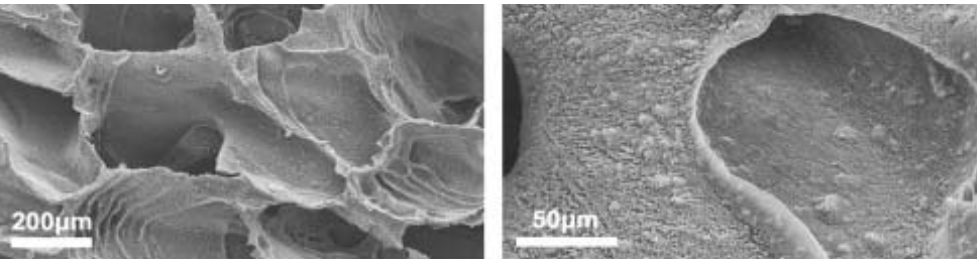
Figure 14. SEM morphology for the porous PLLA/BGC scaffolds with 20 wt.% BGC content: at low-magnification; at high-magnification 20 wt.%. The interconnected pores and nanoparticles studding the surface are visible. Reproduced from [32] with permission from Elsevier.